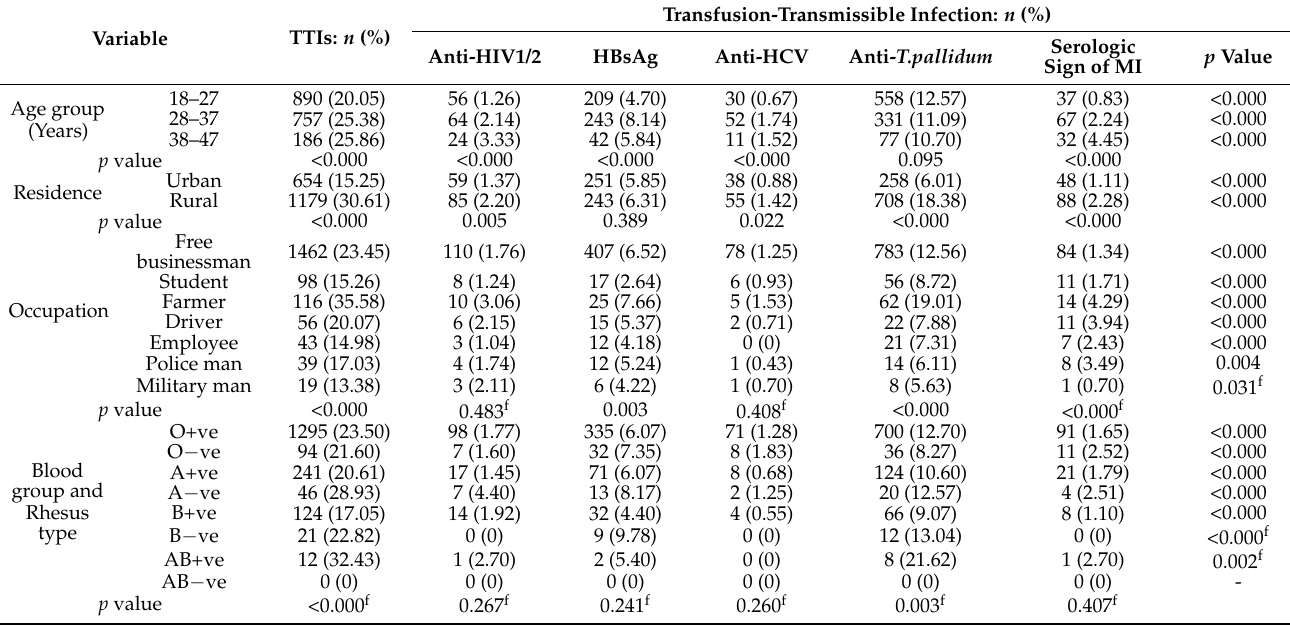
Table 3. Seropositivity rate of the serologic markers of transfusion-transmissible infections (TTIs) in relation to socio- demographic characteristics of blood